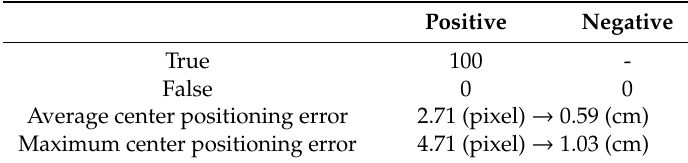
Table 4. Attacker’s handle recognition